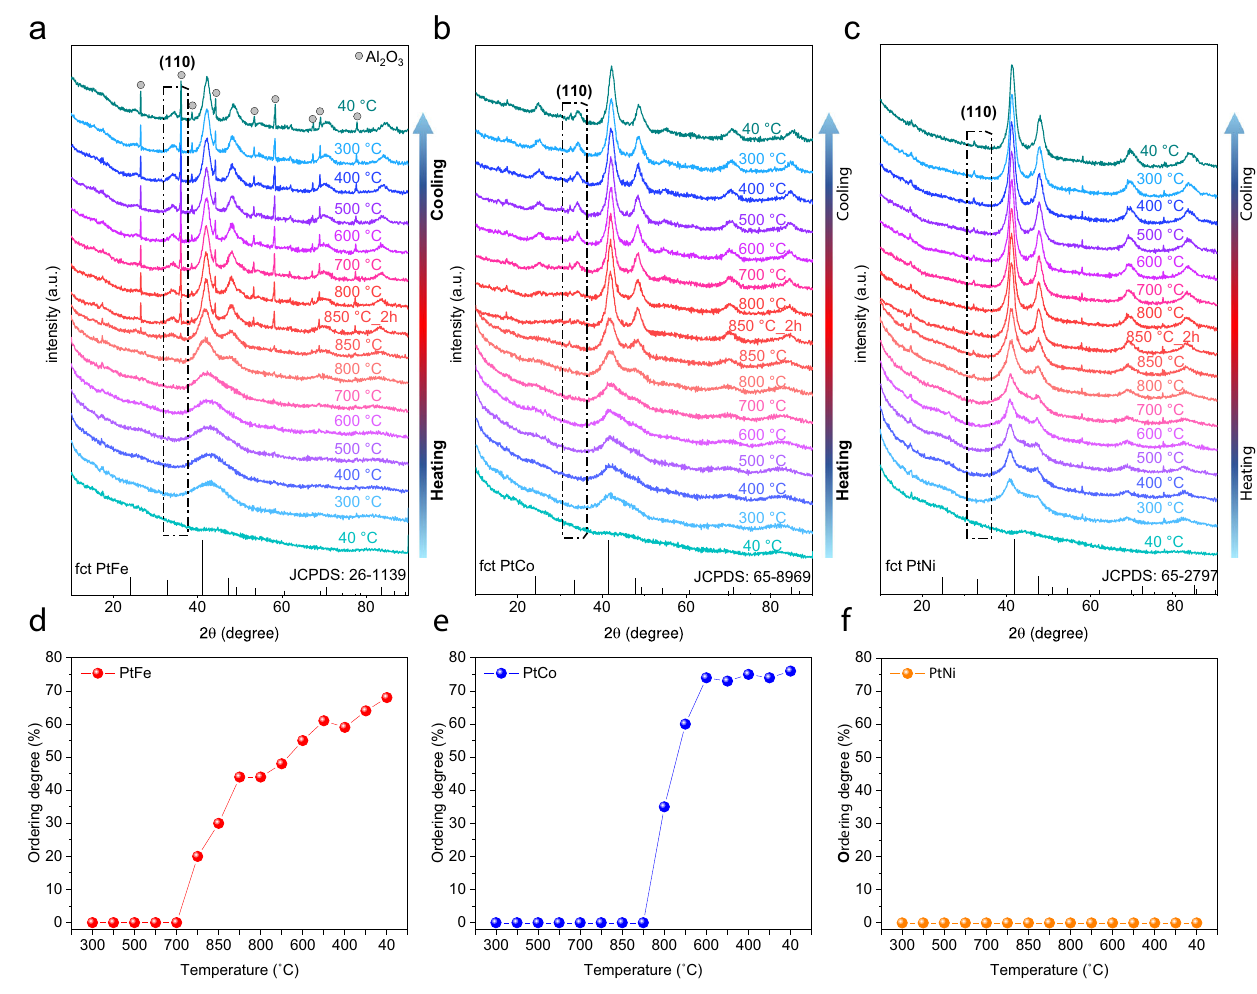
Fig. 2 | In situ high-temperature X-ray diffraction (HT-XRD) results. a – c In situ HT-XRDresults of thePt – Fe,Pt – Co,and Pt – Nicatalysts,respectively.The intensity of the characteristic superlattice peak of (110) re fl ects the evolution of ordered fct IMCs.ThestandardpeaksfororderedfctPtFe(JCPDSno.26-1139),PtCo(JCPDSno.